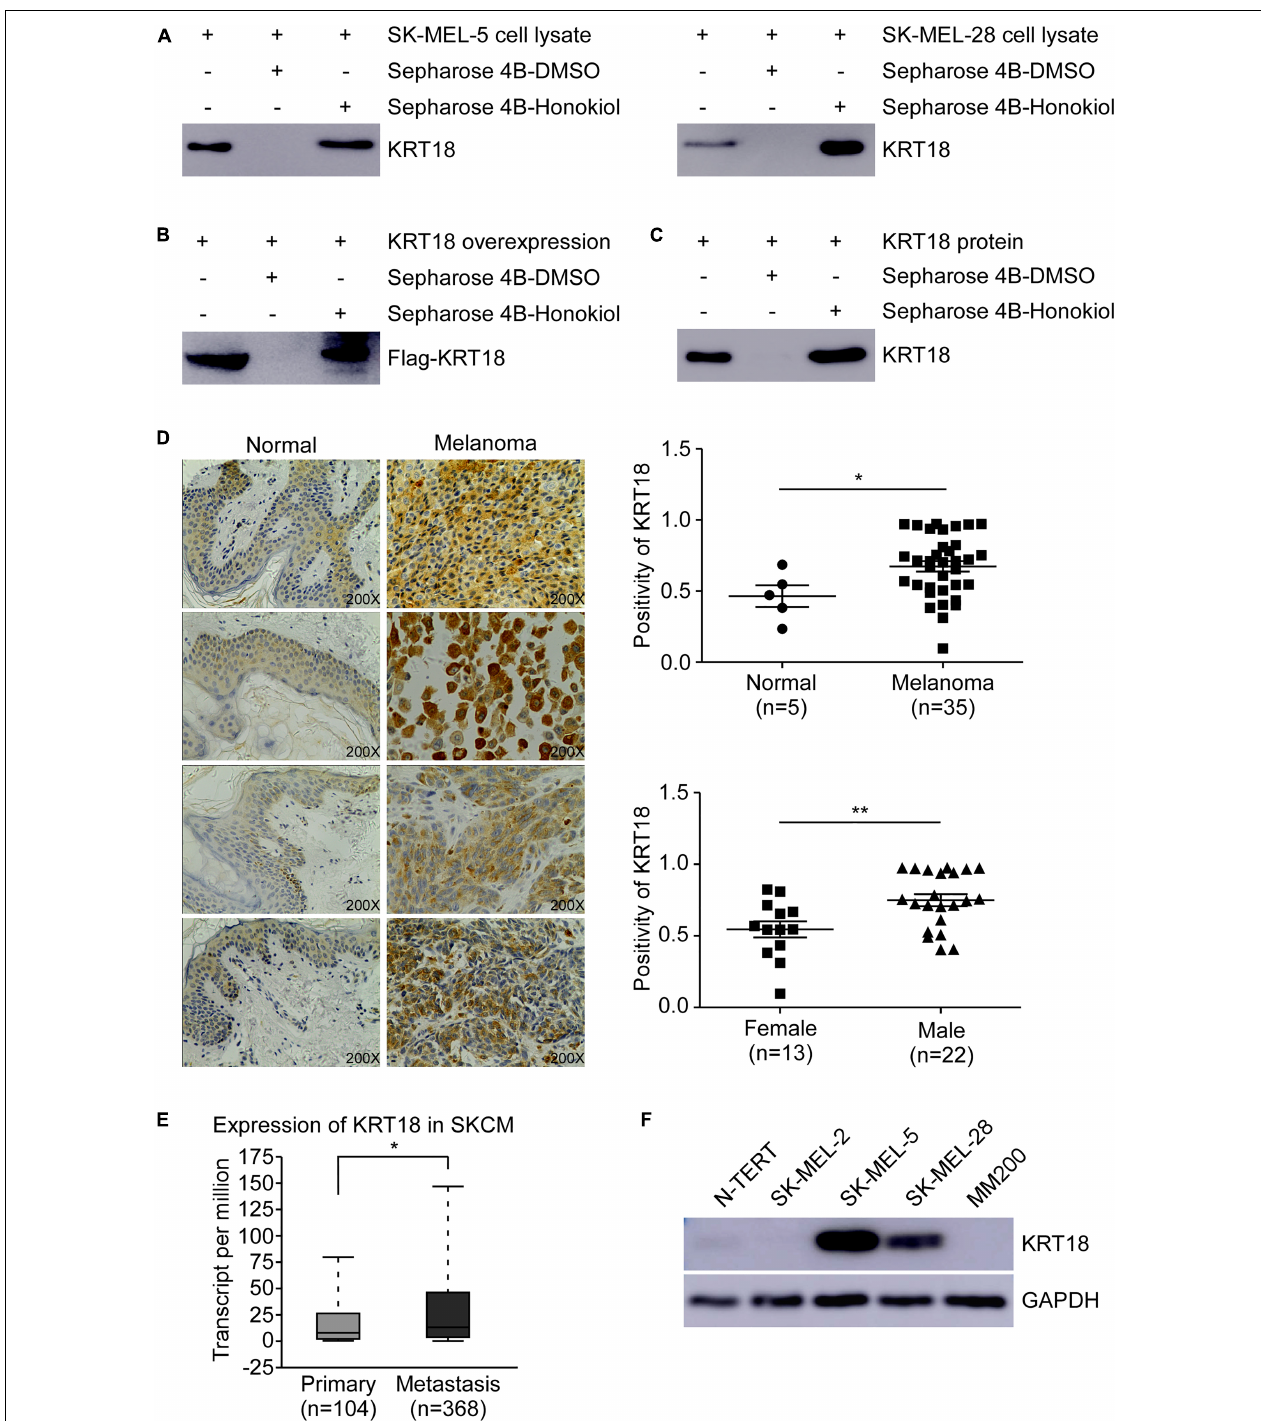
FIGURE 2 | Honokiol directly binds to KRT18, which is highly expressed in some melanoma cells and tissues. Honokiol directly binds to KRT18 (A) in melanoma cell lysate, (B) exogenously and (C) recombinant protein. Proteins were pulled down by Sepharose 4B-honokiol beads or with Sepharose 4B beads and then analyzed by western blotting. (D) Representative images of Immunohistochemical analysis of the melanoma tissue chip (left) and bar graphs showing the number of KRT18 stained cells by IHC staining through image scope (right). KRT18 protein level between normal skin and melanoma tissues (right, above) as well as between male and female melanoma tissues (right, down). (E) KRT18 expression between primary and metastatic melanoma tissues from TCGA database (SKCM: Skin Cutaneous Melanoma). (F) KRT18 protein level between melanoma cell lines and normal skin cell line. The asterisks indicate a significant difference (* p < 0.05 and ** p < 0.01 compared to